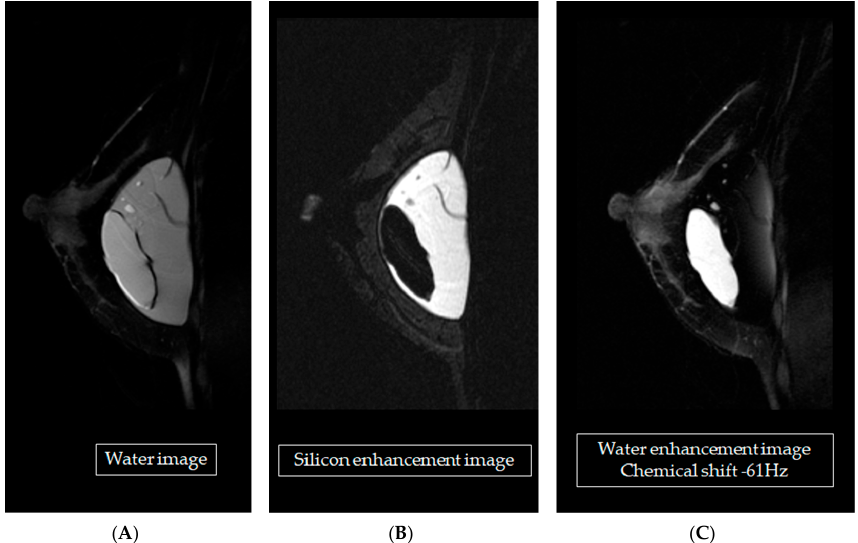
Figure 6. Both saline and silicone bags were implanted in the breasts, the former on the outside of the latter. ( A ) The T2-weighted (T2W) fat-saturation image; ( B ) the same with a chemical shift of − 61 Hz from the water peak.; ( C ) the short-tau inversion recovery water-saturation image with the center frequency at the fat peak.